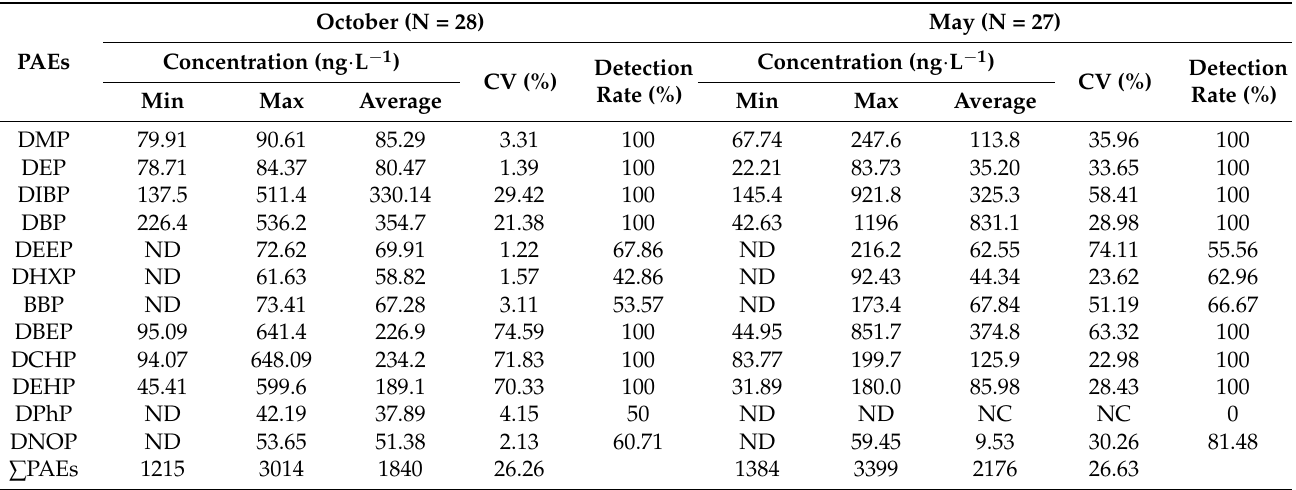
Table 1. Statistical summary of the detected PAE concentrations in the overlying water in Baiyang